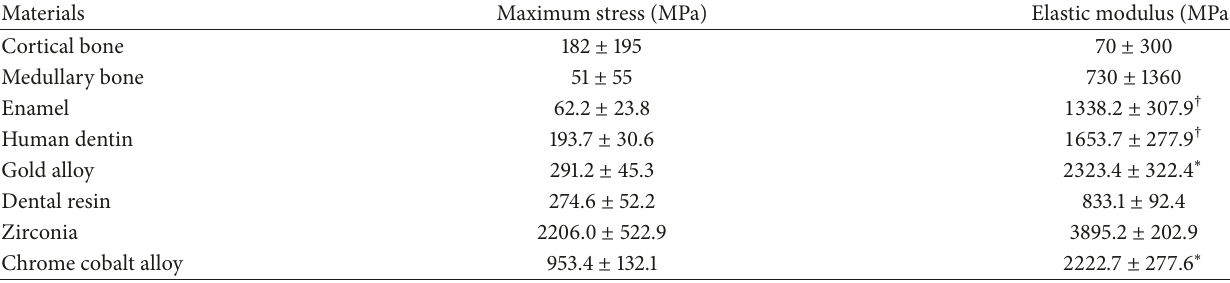
Table 3: Mechanical properties from compression tests ( 𝑛 = 10 for each material) and their hardness values of dental hard tissues and dental restorative materials.